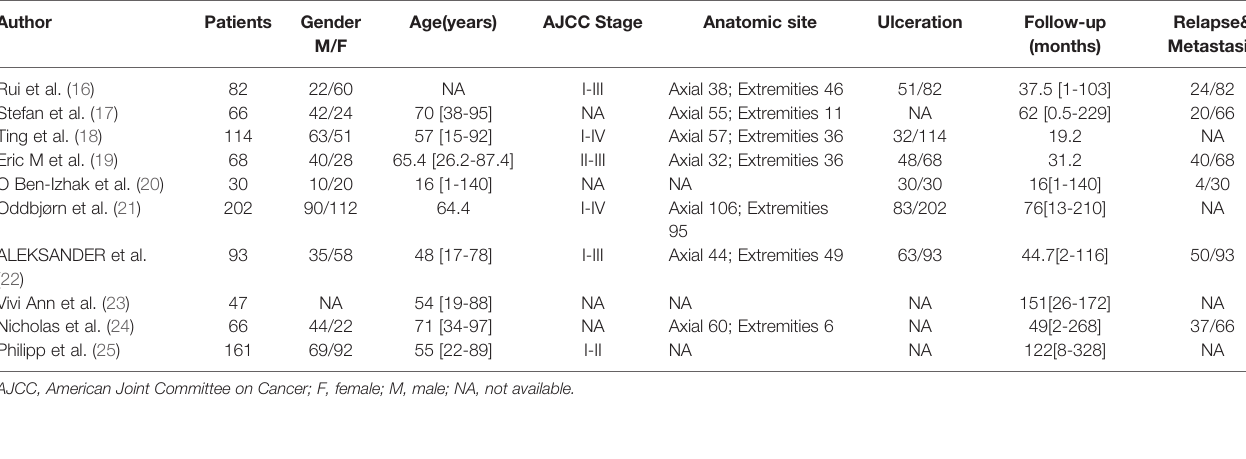
TABLE 2 | Characteristics of patients enrolled in these studies.